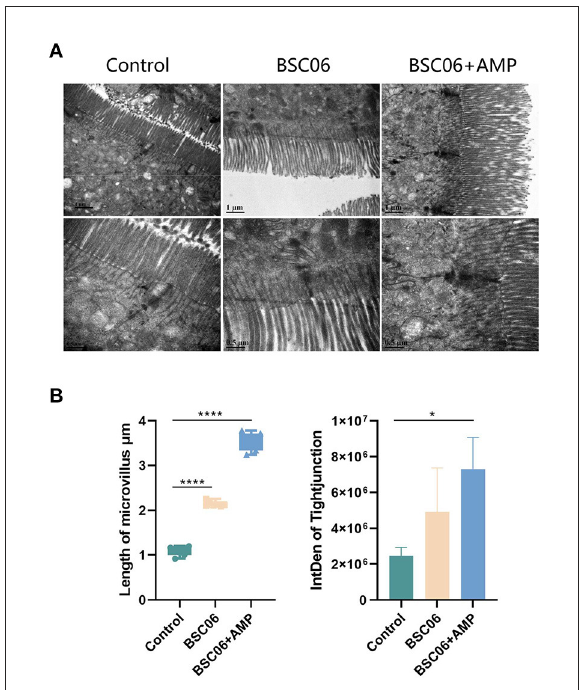
FIGURE1 (A) Transmission electron micrographs of the jejunum microvilli in laying hens. (B) Quantitative analysis of microvilli length ( n = 6) and tight junction ( n = 3) based on TEM (BSC06: Bacillus. amyloliquefaciens SC06 ; BSC06 + AMP: Bacillus. amyloliquefaciens SC06 combined with antimicrobial peptide). Data are presented as the means ± SD for n = 12; * P < 0.05, **** P <